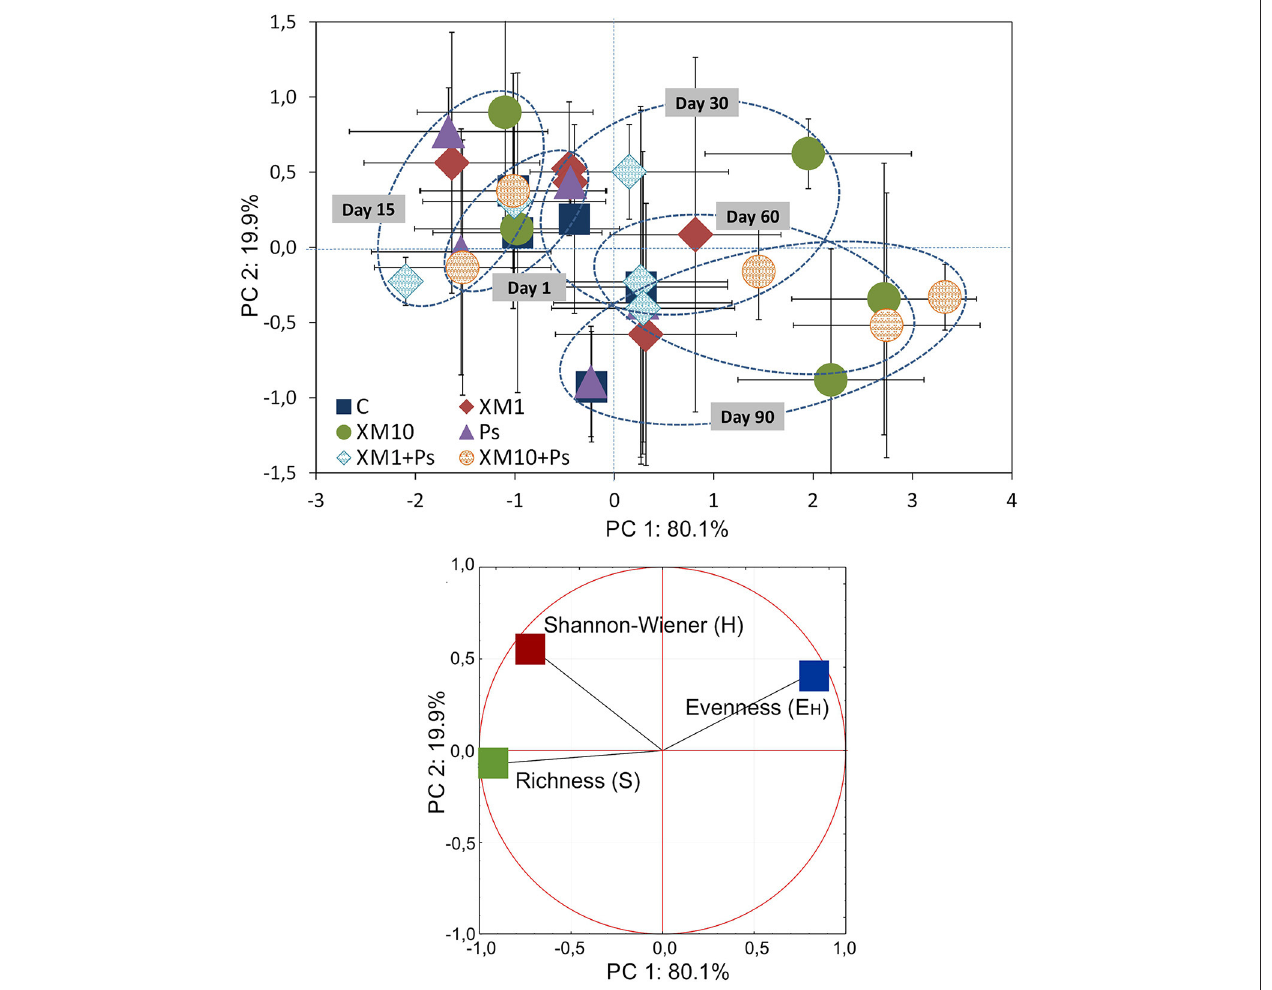
FIGURE 6 | The PC plot for the DGGE indices obtained for all of the sampling days. The explanation of the treatment abbreviations is given in Figure 4